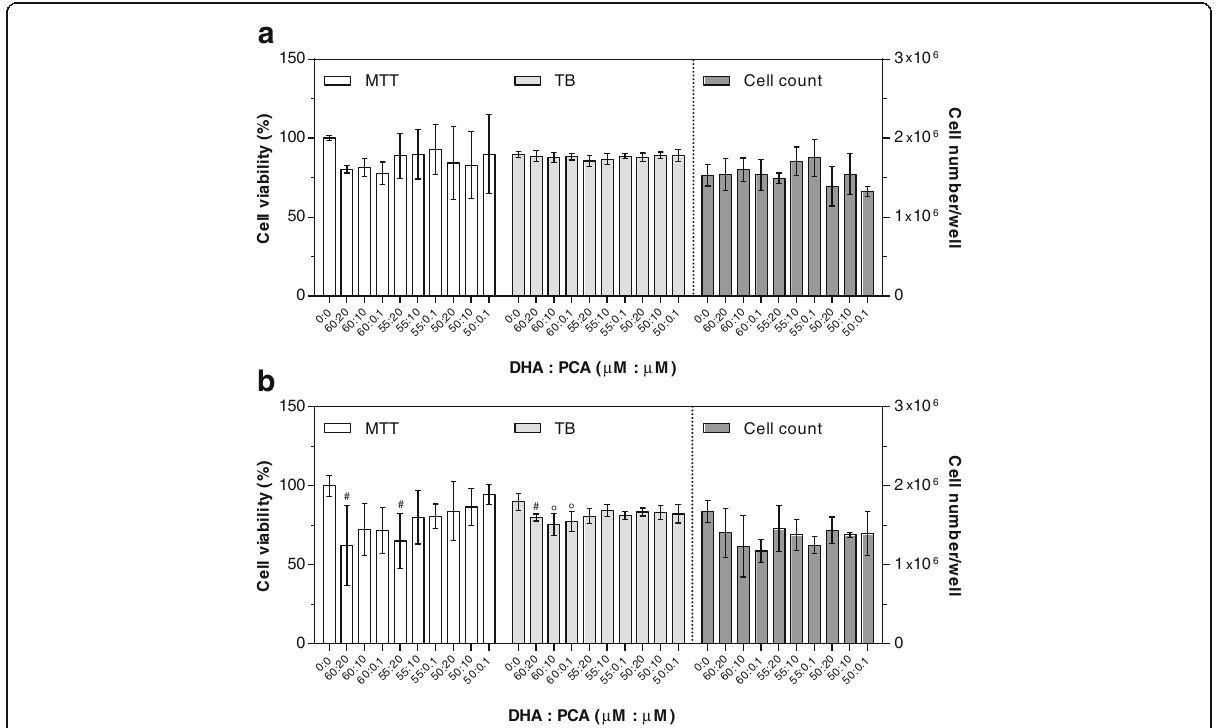
Fig. 7 Cytotoxic effects of DHA plus PCA after 24 ( a ) and 48 ( b ) hours of supplementation. Cell viability by MTT is expressed as percentage of control cells (assigned as 100%). TB is expressed as percentage of total cells. Cell count is expressed as number of cells per well. Data are means ± SD of six samples obtained from two independent experiments. Statistical analysis was by the one-way ANOVA (panel a : cell count p < 0.01, MTT p < 0.001, TB n.s; panel b : MTT p < 0.05, TB p < 0.05, cell count n.s.) using Dunnett ’ s as post-test to compare supplemented cells to control ones (# p < 0.05; ° p <